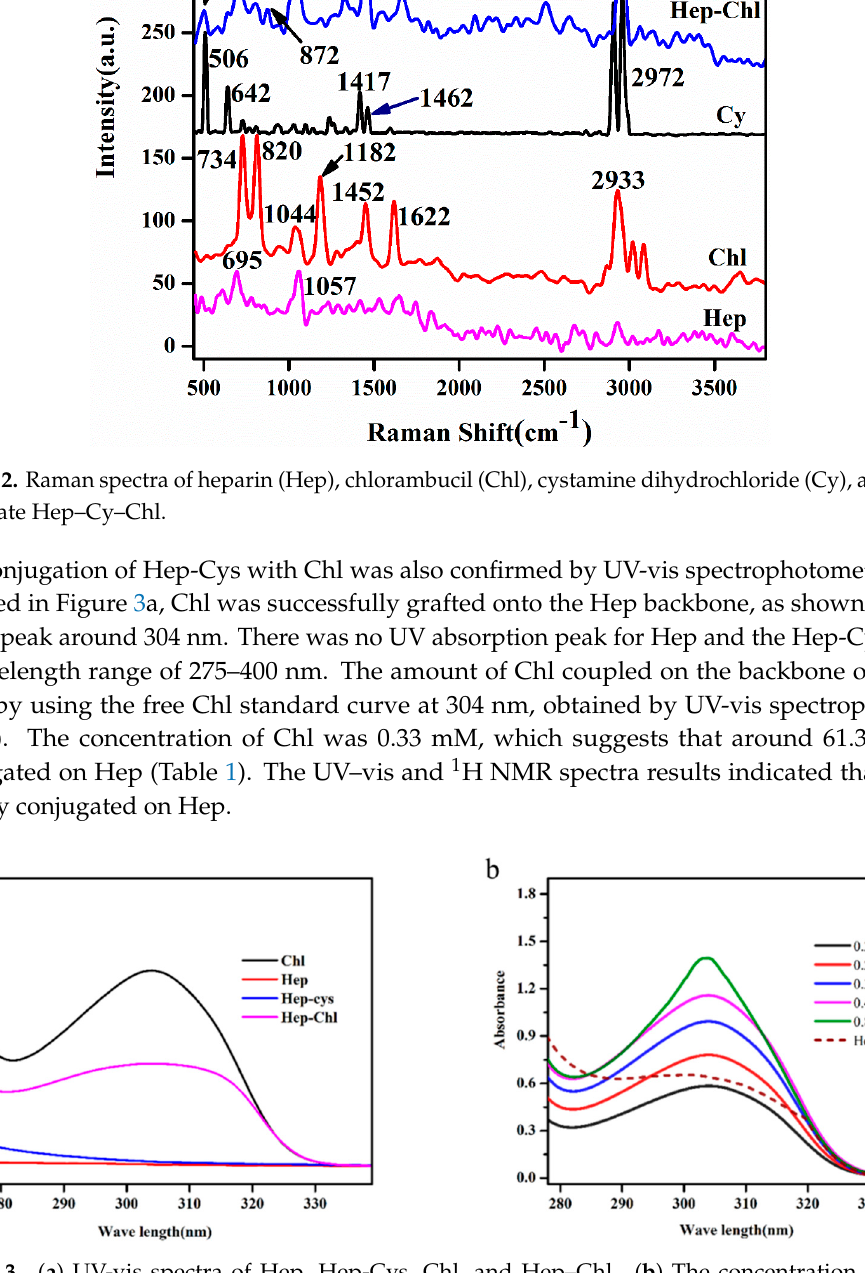
Figure 3. ( a ) UV-vis spectra of Hep, Hep-Cys, Chl, and Hep–Chl. ( b ) The concentration of Chl absorbance for the calibration curve at 304 nm.